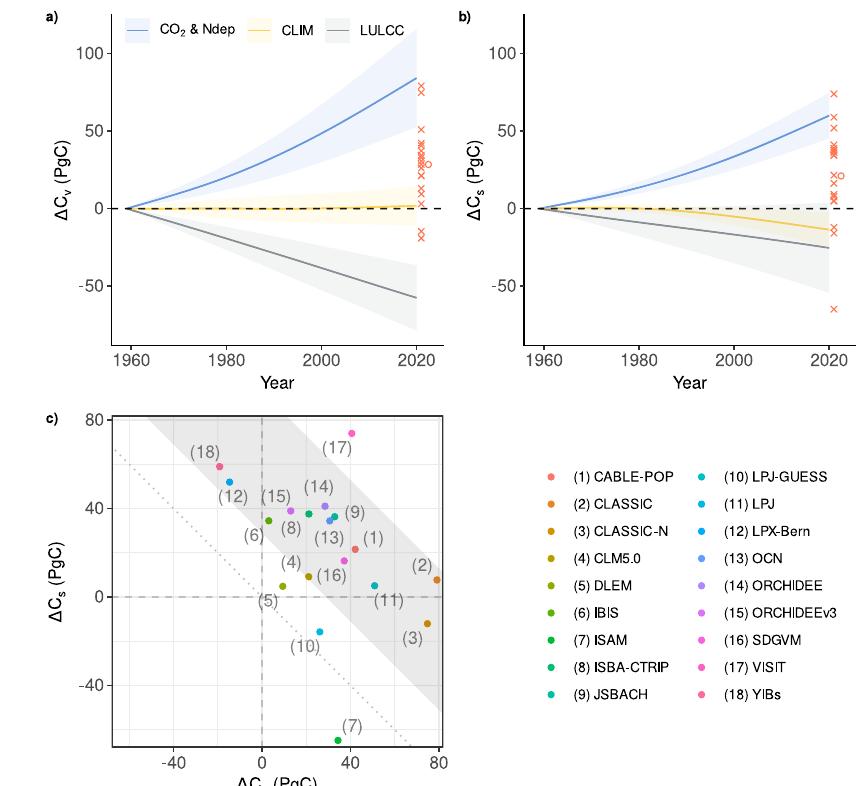
Fig. 3 | Temporal changes in global vegetation and soil carbon stocks. Time- series show the change in global a vegetation ( Δ C v ) and b soil ( Δ C s ) carbon stocks from 1959 – 2020 due to each of the three external drivers (CO 2 and N deposition, climate,land-use,andlandcoverchange).Linesrepresentthemeanofthedynamic global vegetation models (DGVMs) and shading the ±1 σ of the DGVMs. The DGVM